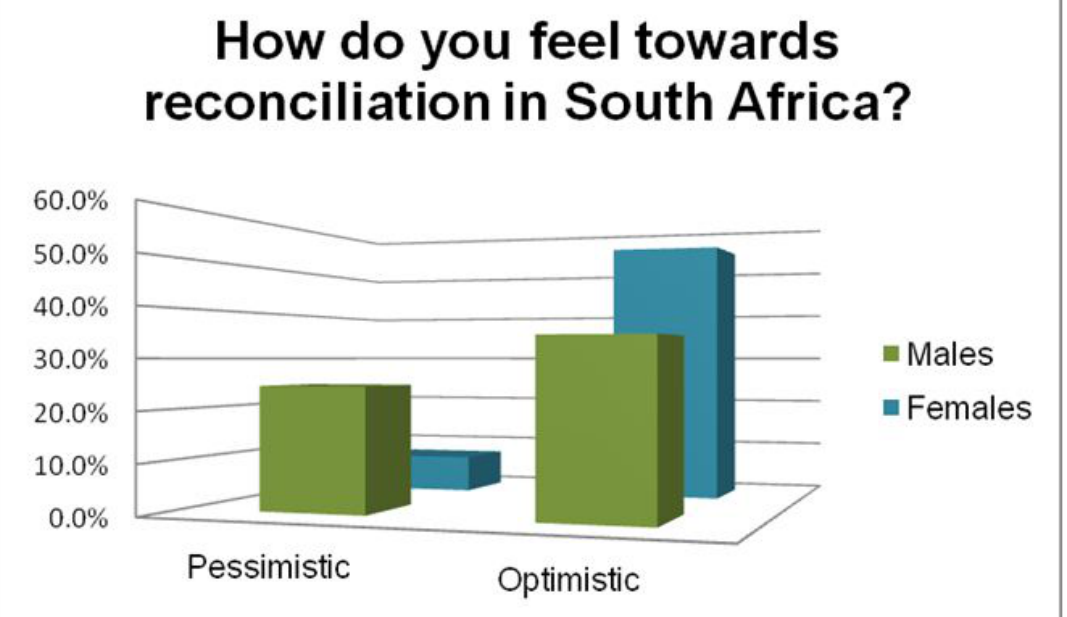
Figure 7: Gender-based views concerning reconciliation in South